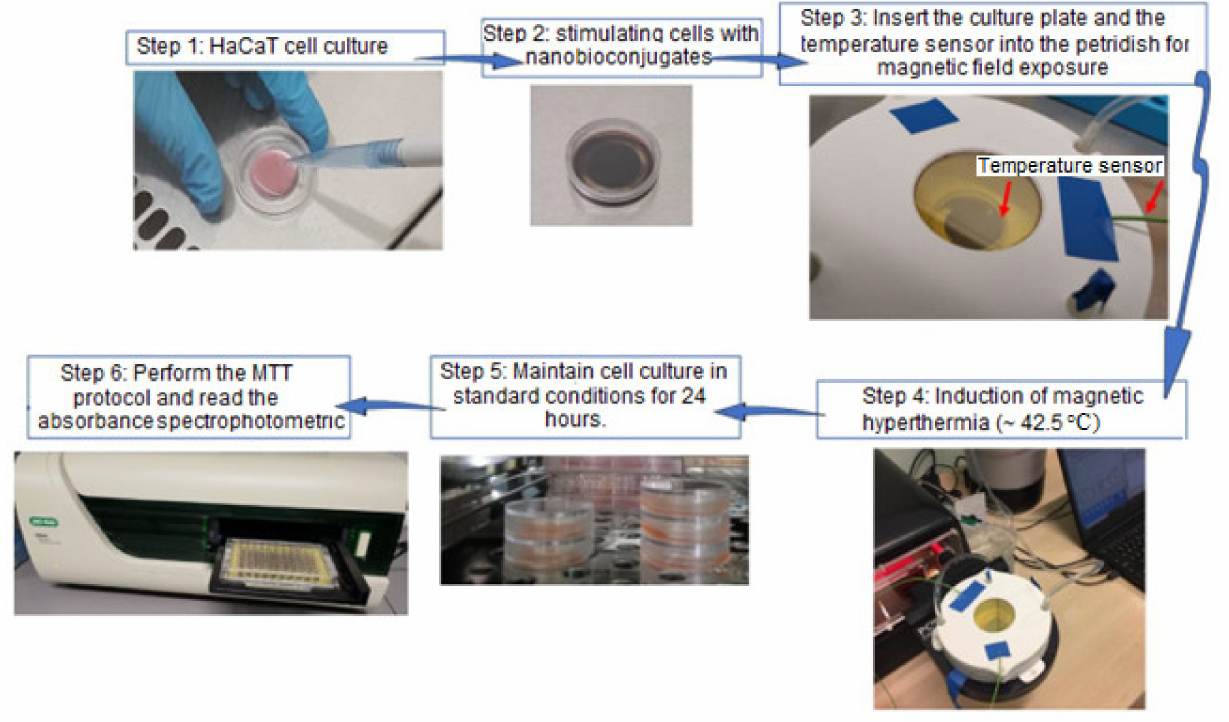
Figure 1. Schematic representation of the working protocol for achieving magnetic hyperthermia in vitro along with the cell viability assessment by means of the MTT